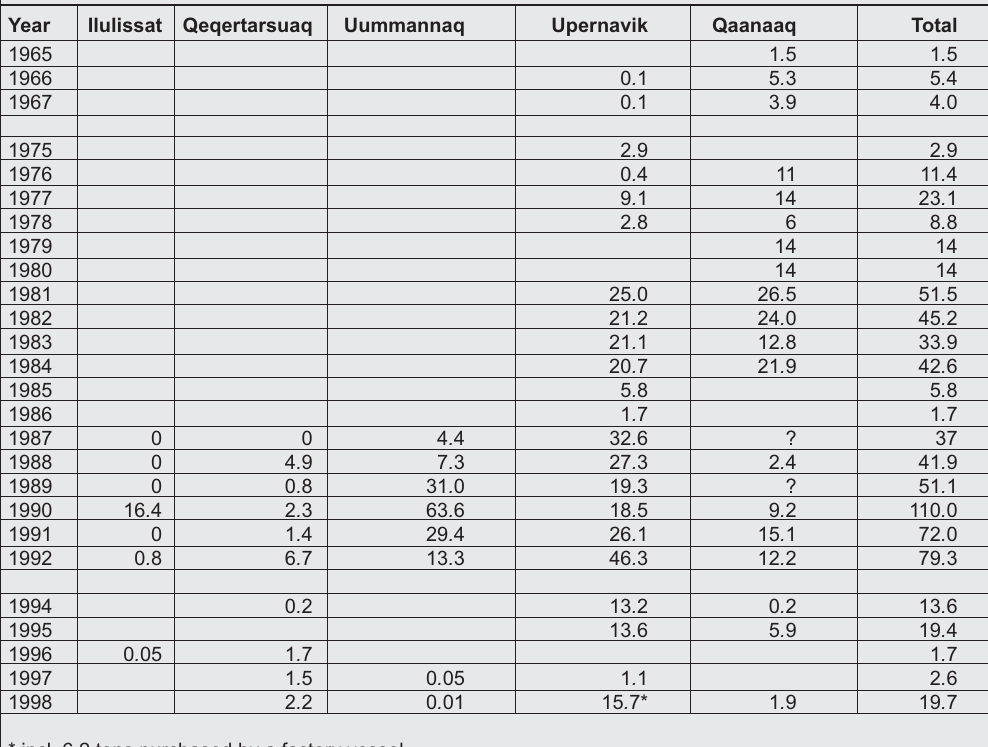
Table 2 . Purchases (in tons) of beluga mattak per area (data from 1965-1992 from Heide- Jørgensen (1994), Upernavik 1975-1978 from Upernavik Museum and from 1994 to 1998 com- piled by Greenland